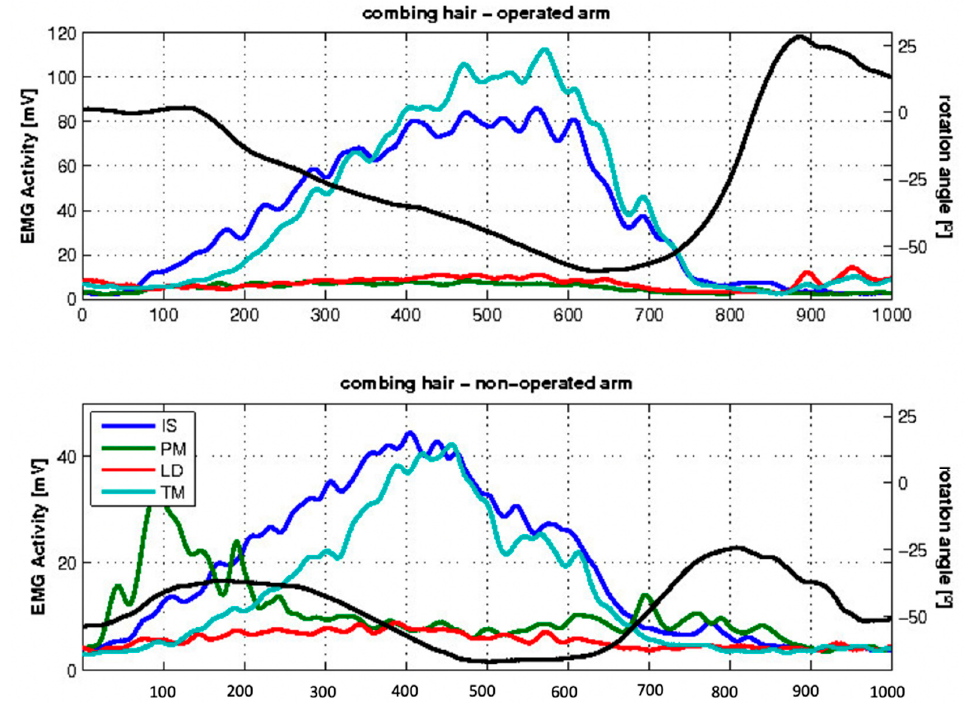
Figure 5. Mean EMG activity during the activity of daily life (ADL) of combing hair for the examined patients. The x-axis indicates the frames, and the y-axis indicates, on the left side, the EMG activity in mV of the different muscles (colored lines) and, on the right side, the angle of rotation represented by the black line. Negative values show exo-rotation, and positive values endorotation.